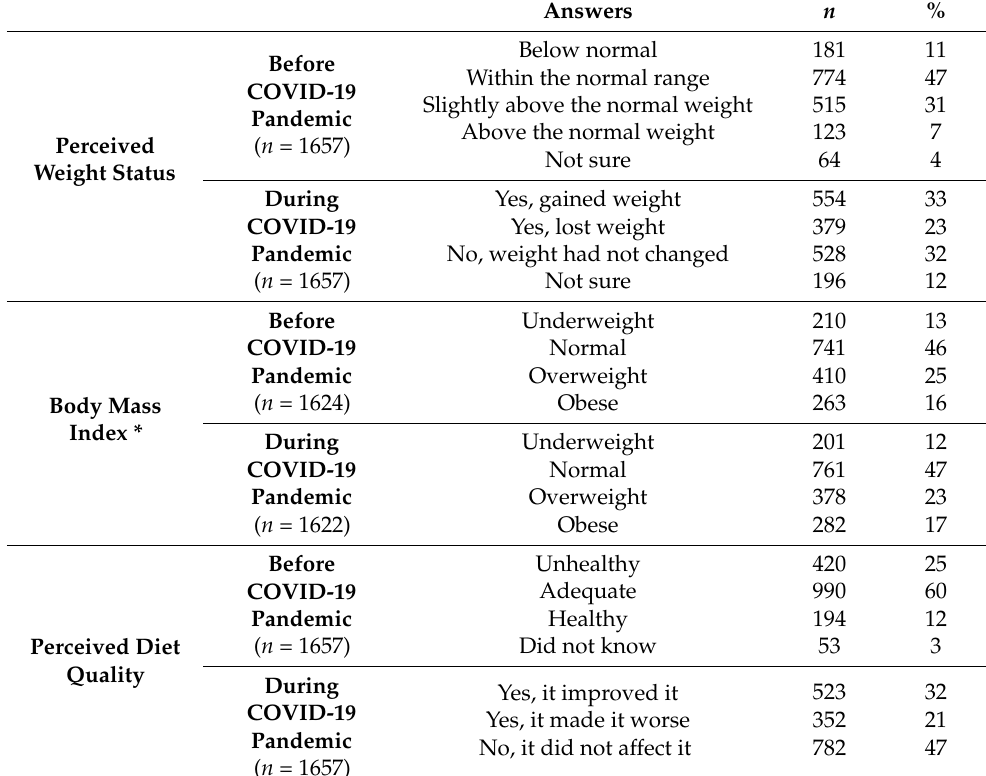
Table 2. Perceived weight status, body weight, and quality of diet before and during the COVID-19 pandemic ( n =